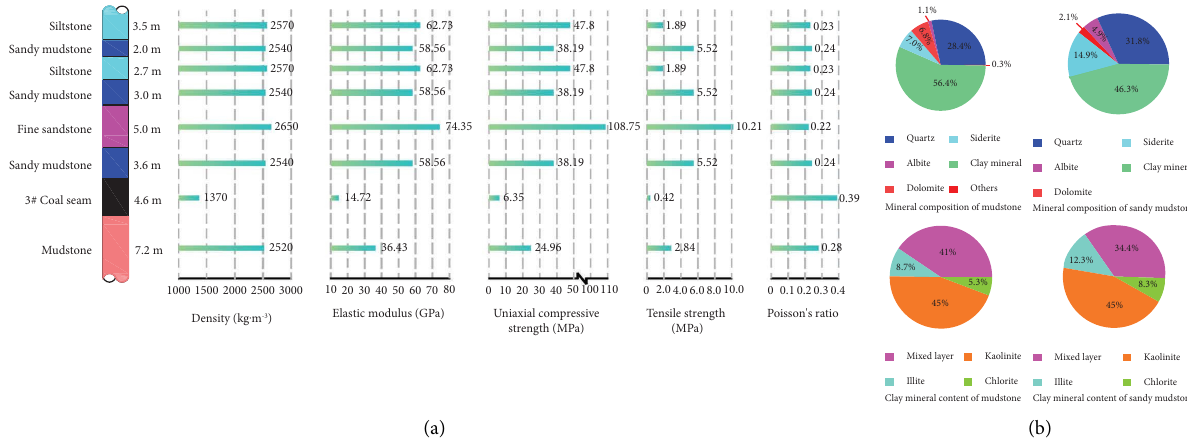
Figure 1: Rock properties of roof and foor: (a) rock stratum histogram; (b) mineral